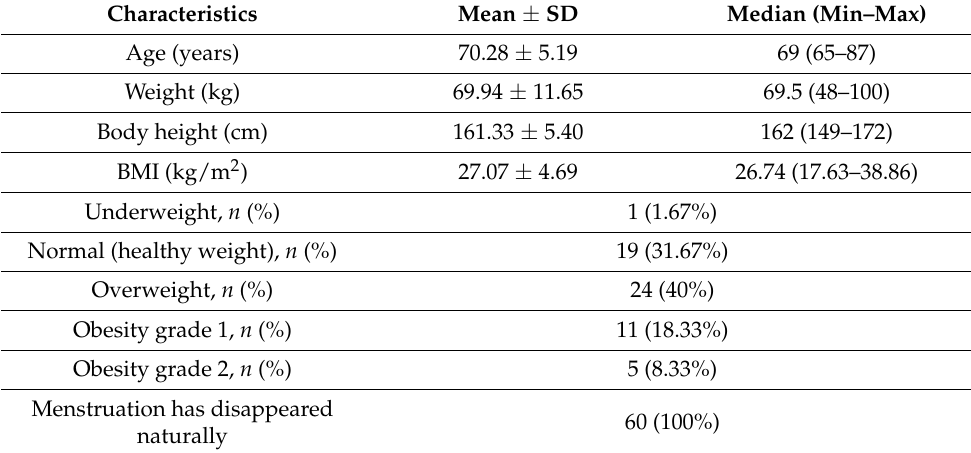
Table 1. Characteristics of the studied group.